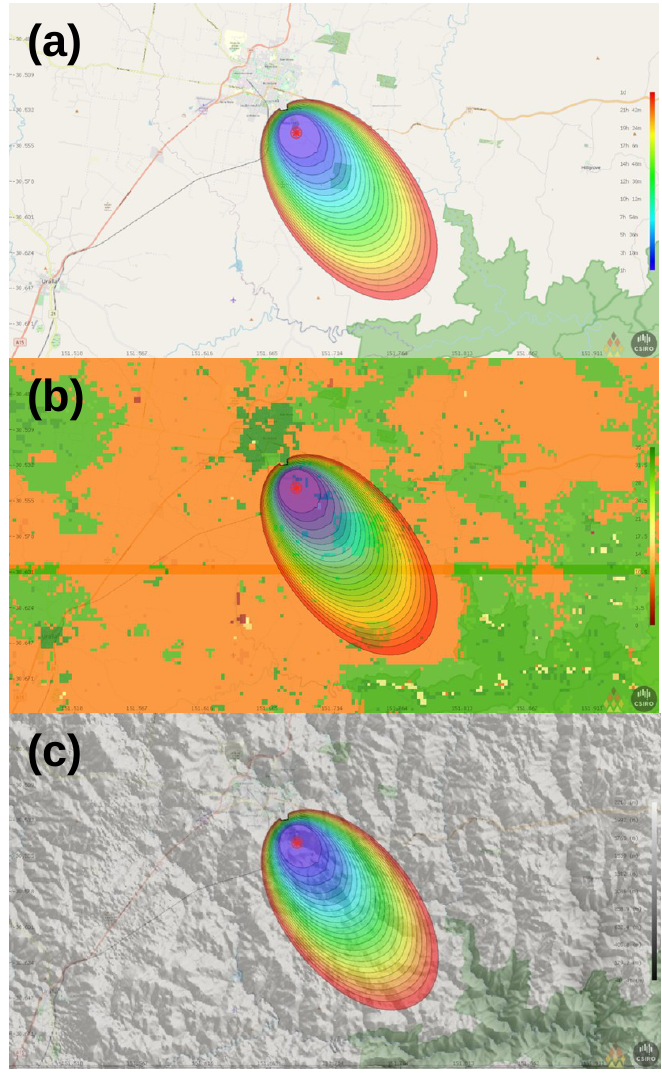
Figure 13. Simulation results of fire spread in the Armidale region over a 24 h period: ( a ) basemap; ( b ) with vegetation-type basemap; ( c ) with terrain